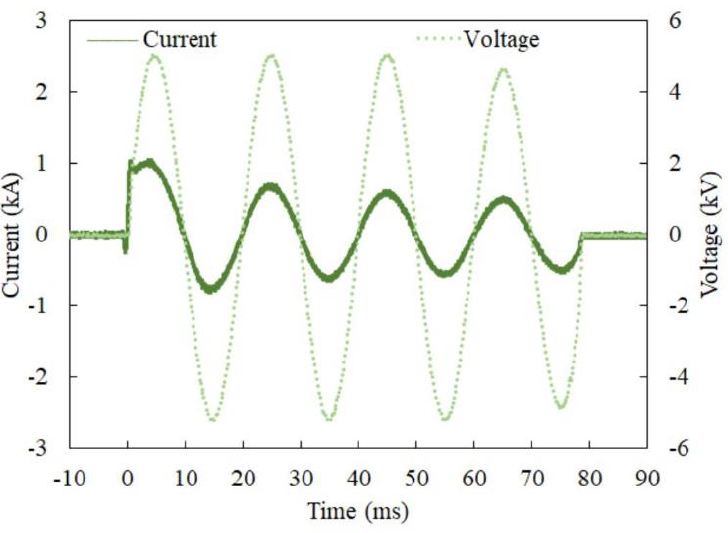
Figure 7. Voltage across the SFCL and current courses during short-circuit test at 80 K.